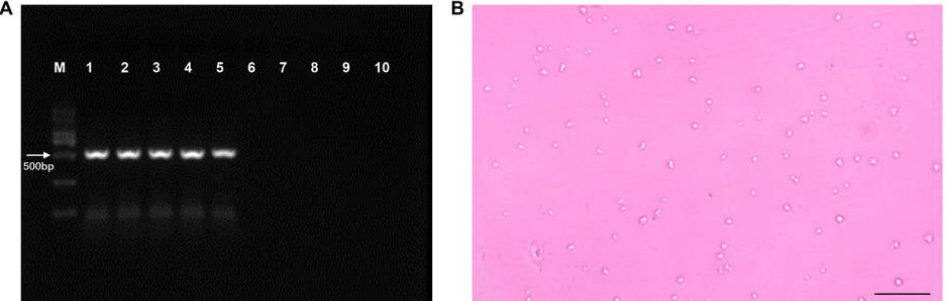
Figure 1. Detection of EHP infection of Palaemon carinicauda . ( A ) PCR detection of EHP in P. carini- cauda . M, marker; 1–5, positive samples; 6–10, negative samples. ( B ) EHP spores collected from EHP-infected shrimp, scale bar 20 µ